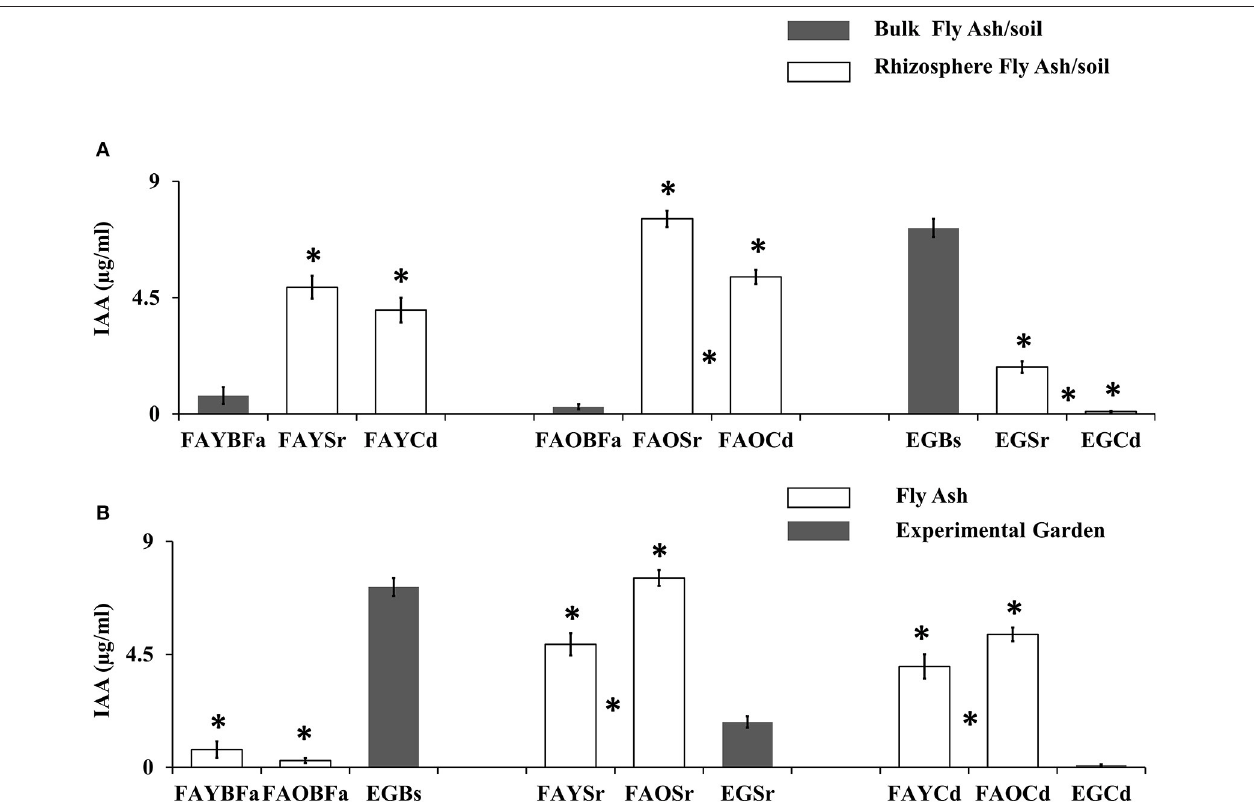
FIGURE 2 | (A) Comparison of microbial IAA production from non-rhizosphere (bulk) and rhizosphere ( S. ravennae and C. dactylon ) from fly ash dumps and experimental garden. “*” Above the bar indicates significant difference from the non-rhizosphere region. “*” Between the bars indicates a significant difference between S . ravennae and C. dactylon rhizosphere ash/soil samples. (B) Comparison of microbial IAA production from old fly ash dump, young ash dump and experimental garden. “*” Above the bar indicates significant difference from the experimental garden. “*” Between the bars indicates a significant difference between a young dump and old dump. All data are presented as mean ± SE of IAA ( µ g/ml) production by bacterial communities; Significant differences were calculated using Independent sample t -test ( p <